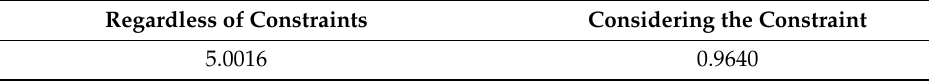
Table 2. RMSE of trajectory tracking error on ice-covered pavement.